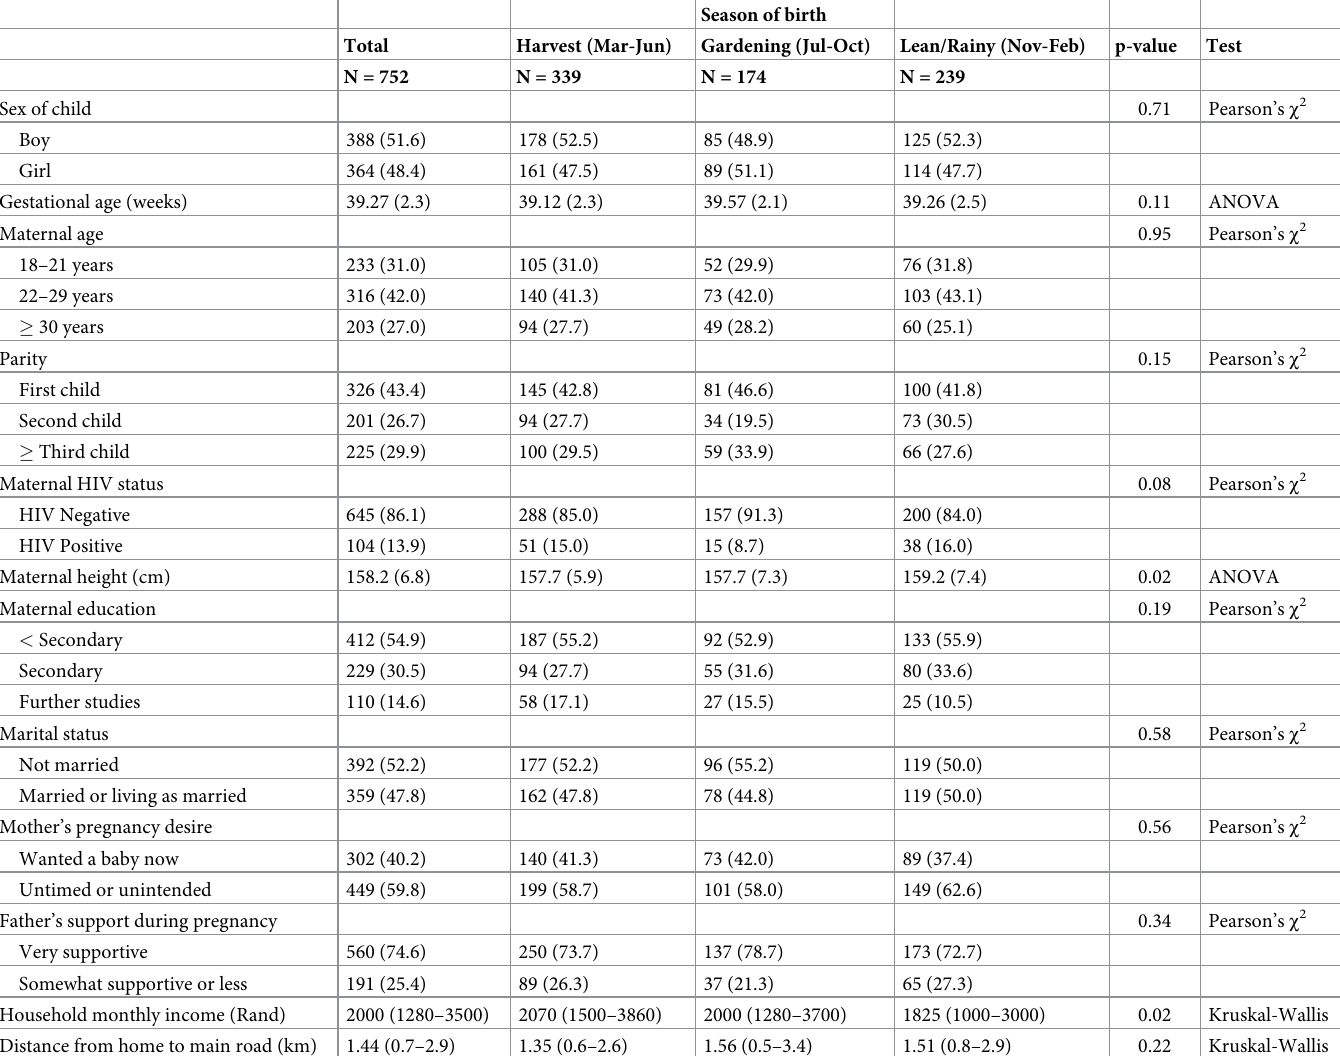
Table 1. Characteristics of mother-infant pairs by season of birth, VHEMBE study, South Africa,